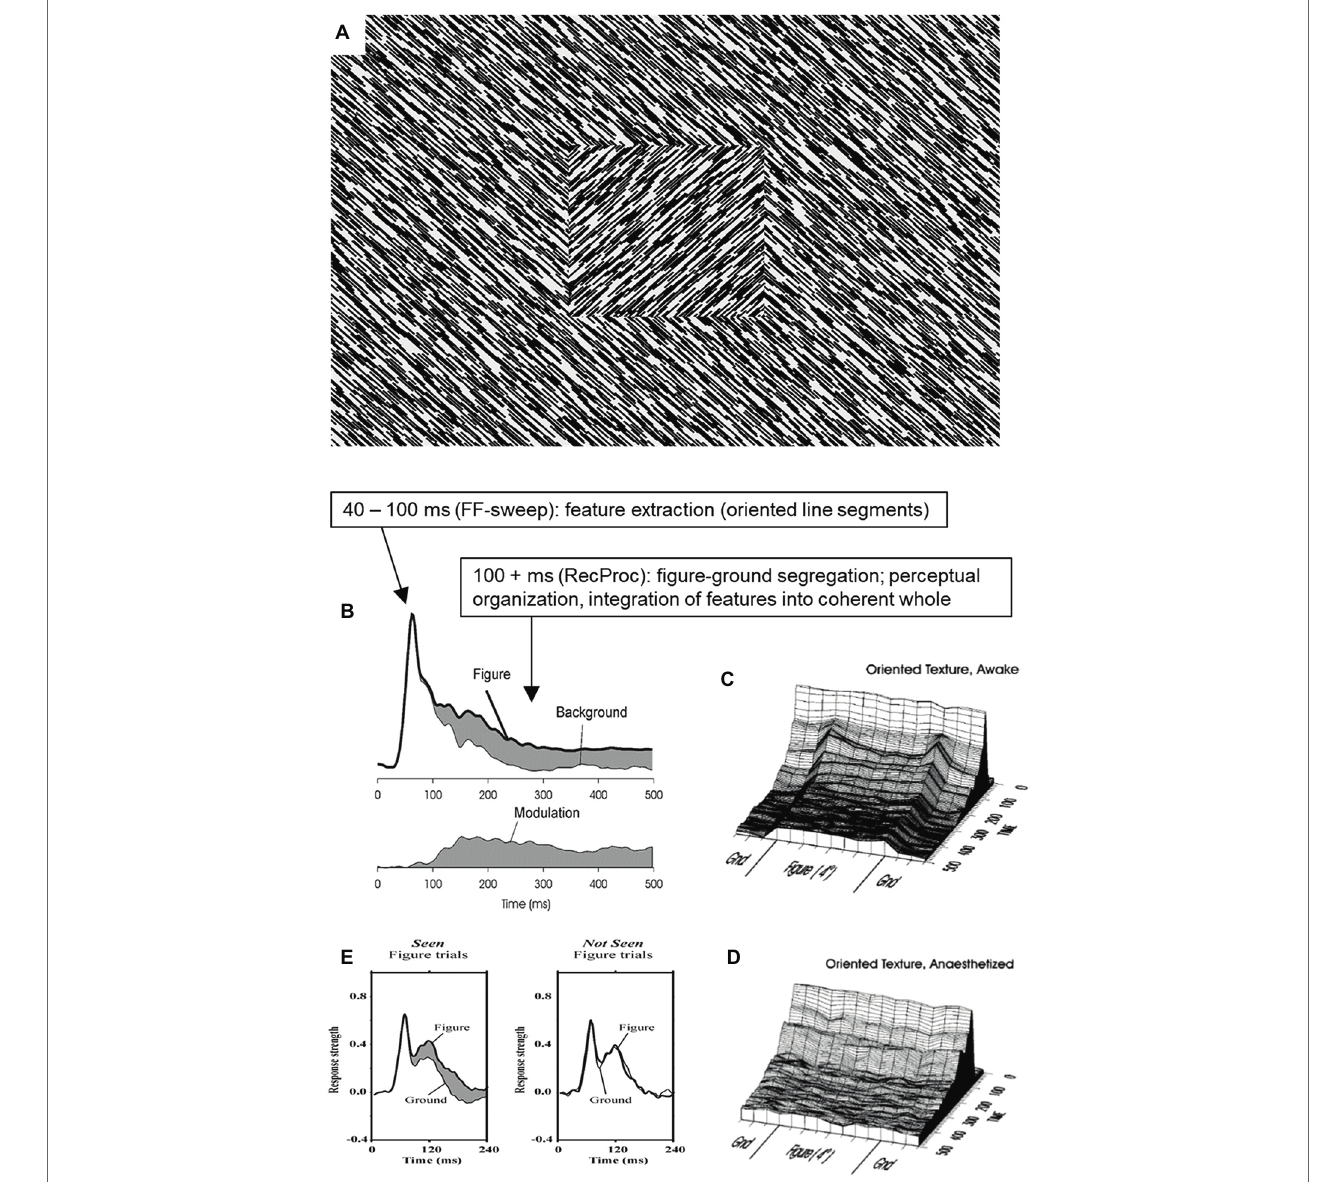
FIGURE 2 | The neural processing of figure ground organization and its relation to conscious perception. (A) A typical figure-ground stimulus as used in many studies (of the author) on the relation between perceptual organization and conscious vision. (B) Typical result from recording responses in monkey primary visual cortex (V1) to the stimulus shown in (A) . Note how the initial response is identical for line segments belonging either to figure or background, yet that later responses reflect the processing of figure versus background (Lamme, 1995; Zipser et al., 1996). (C) Contextual modulation reflects figure-ground segregation as modulation is uniformly elevated for the figure region (Lamme et al., 1999). (D) When anesthetized, feedforward activation and detection of line segments is still present, yet the figure-ground modulation is selectively absent (Lamme et al., 1998). (E) When figures are not seen, feedforward V1 responses persist, but figure-ground modulation is selectively absent (Supèr et al., 2001). © (1998) National Academy of